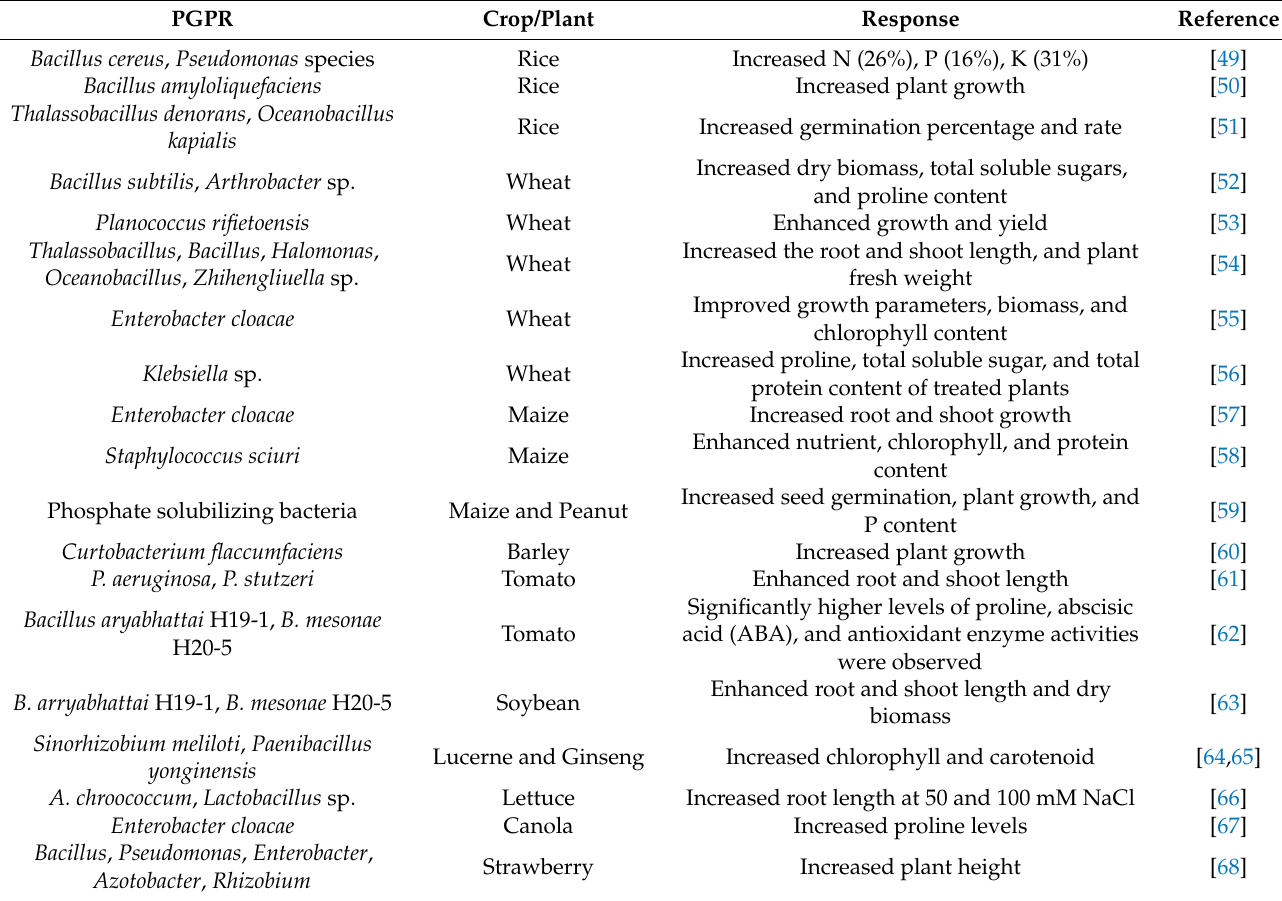
Table 1. Role of PGPR in crop/plant improvement under salinity